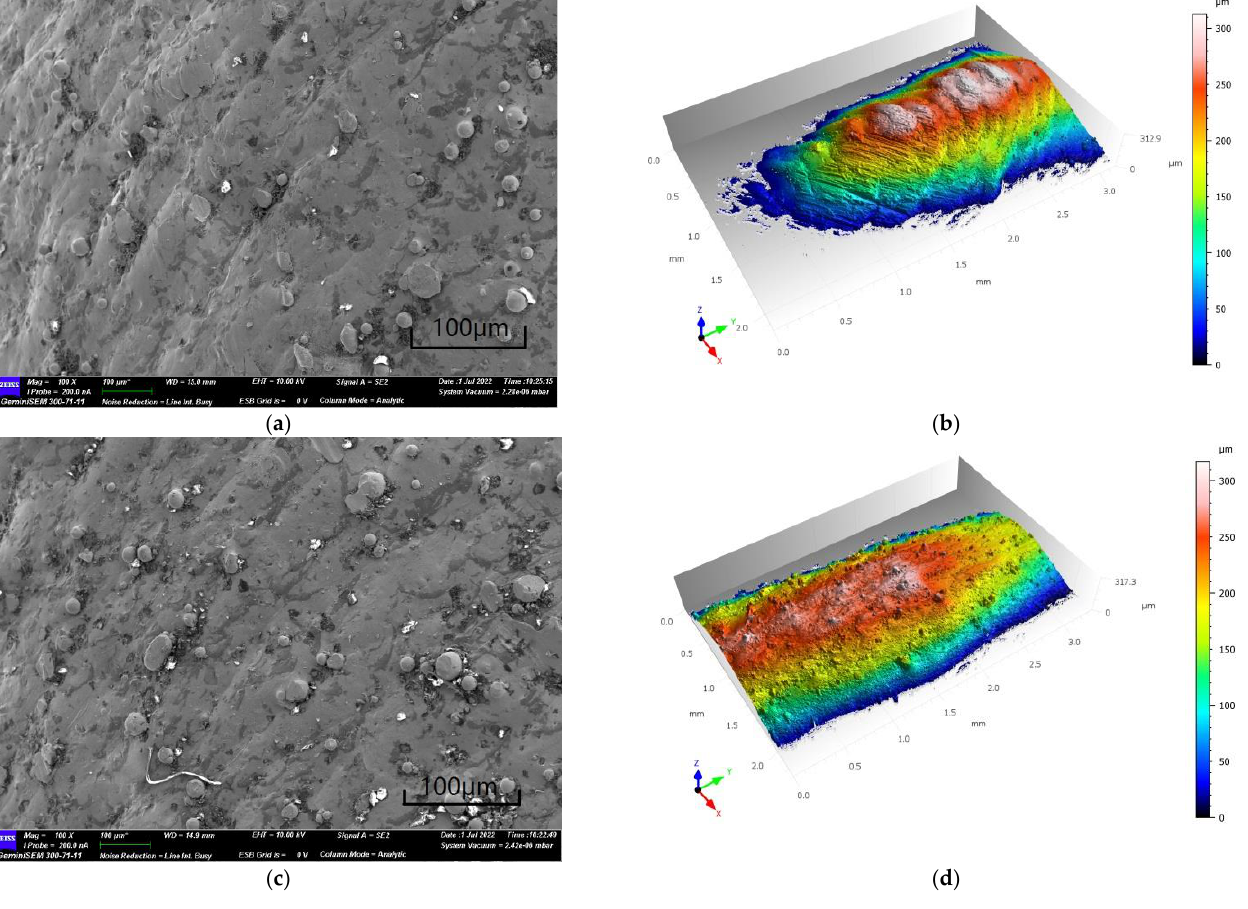
Figure 9. SEM images and 3D profiles of Part C ’ : ( a , b ) horizontal plane; ( c , d ) vertical surface.